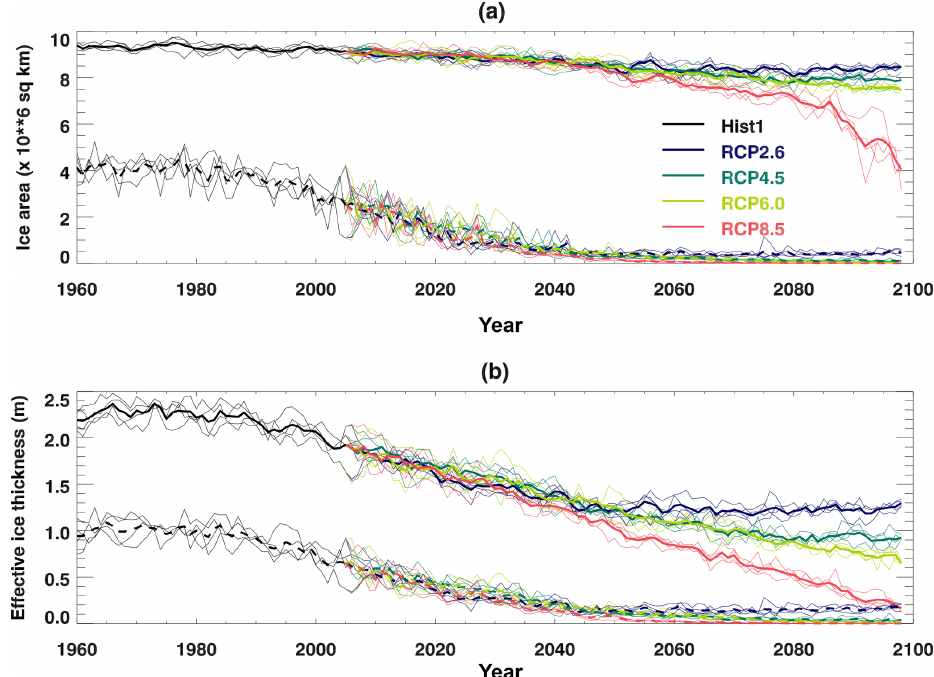
Figure 3. Evolution of (a) the ice area and (b) the mean effective ice thickness for March (solid lines) and September (dashed lines) over the region defined in Fig. 2 for each of the HadGEM2-ES integrations. Bold lines show the ensemble means, and thin lines show the individual ensemble members in each